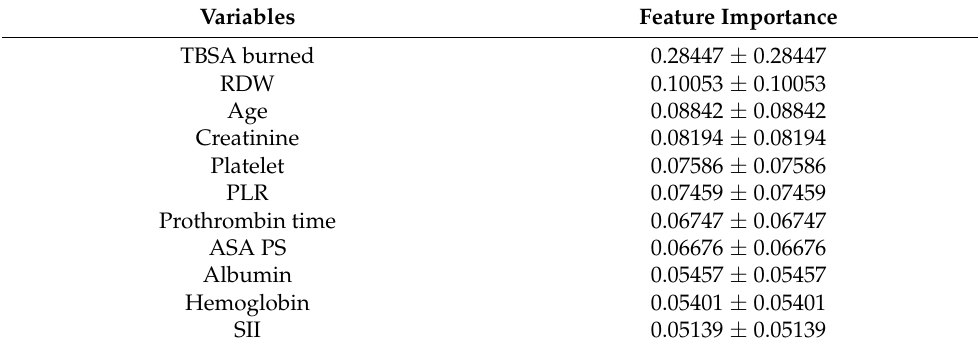
Table 3. Feature importance of the variables associated with mortality after burn surgery.